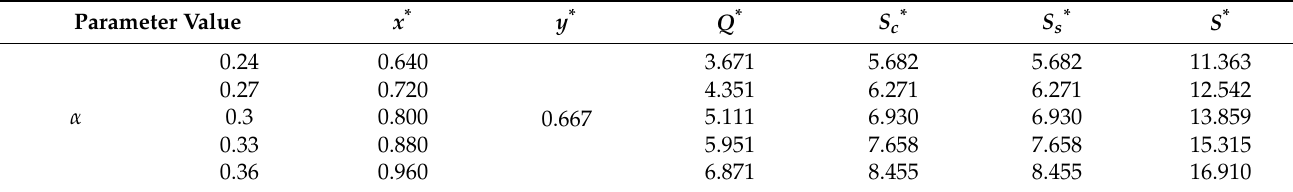
Table 3. Impact of QB coefficient α on equilibrium solution.